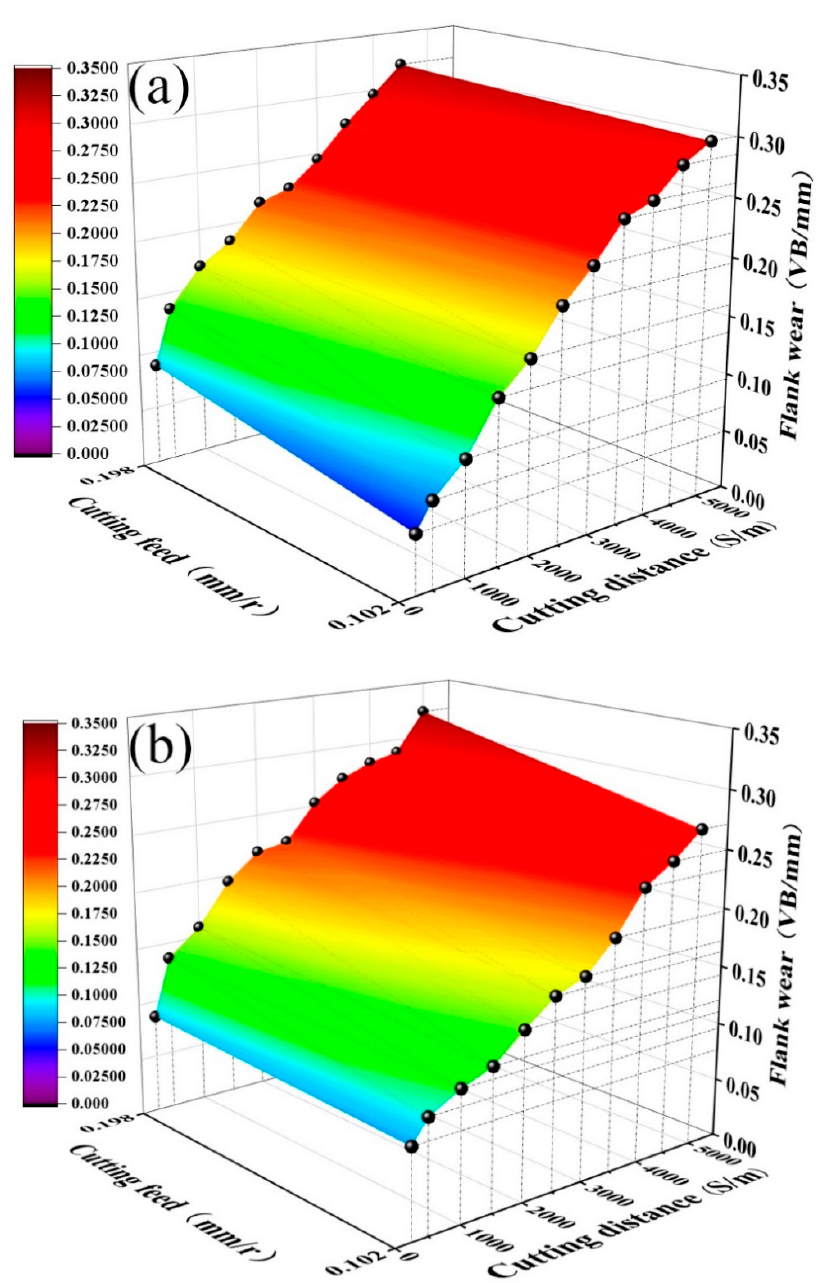
Figure 6. Curves of flank wear VB against cutting distance S under different cutting feed rates: ( a ) ( a ) ATS, ( b ) ATS, ( b ) ATSC10.